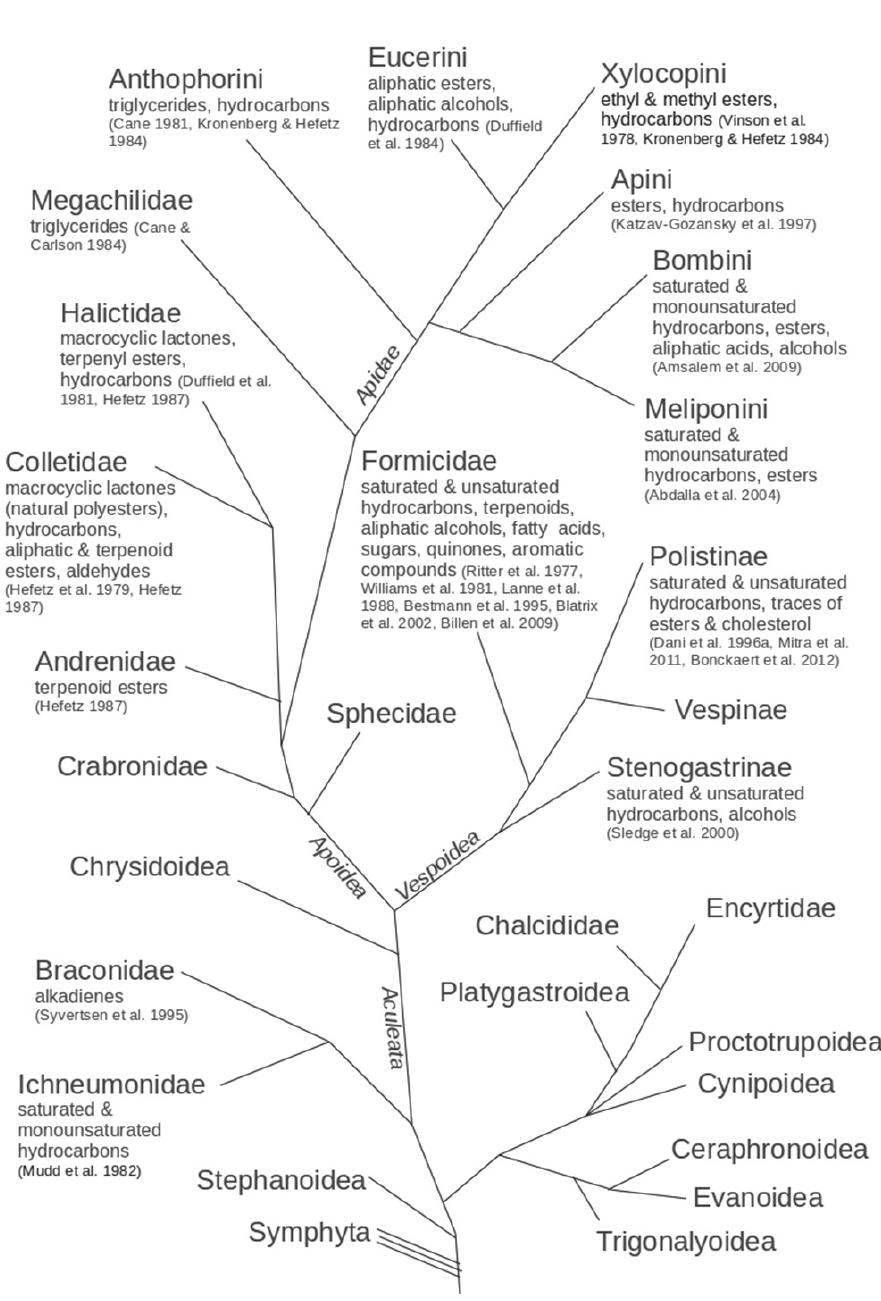
Figure 2. Diagram listing the categories of compounds reported from the Dufour’s gland in various hy- menopteran taxa, also showing the inter-relationships of the taxa. Dendrogram made following Brothers (1998), Schmitz and Moritz (1998), Whitfield and Cameron (1998), Grimaldi and Engel (2005), Brady et al. (2009), Vincent et al. (2010), and Cardinal et al. (2010). References cited in parenthesis below the names of compounds. Branch lengths do not have any